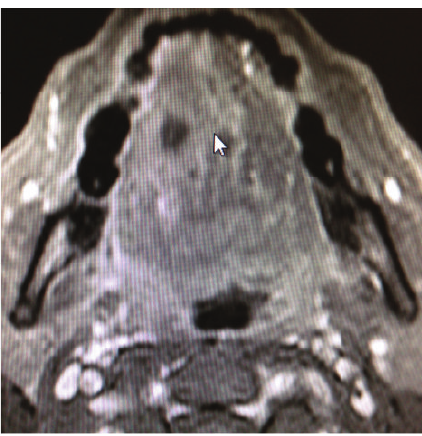
Figure 1: MRI of the neck revealing an anterior tongue mass.